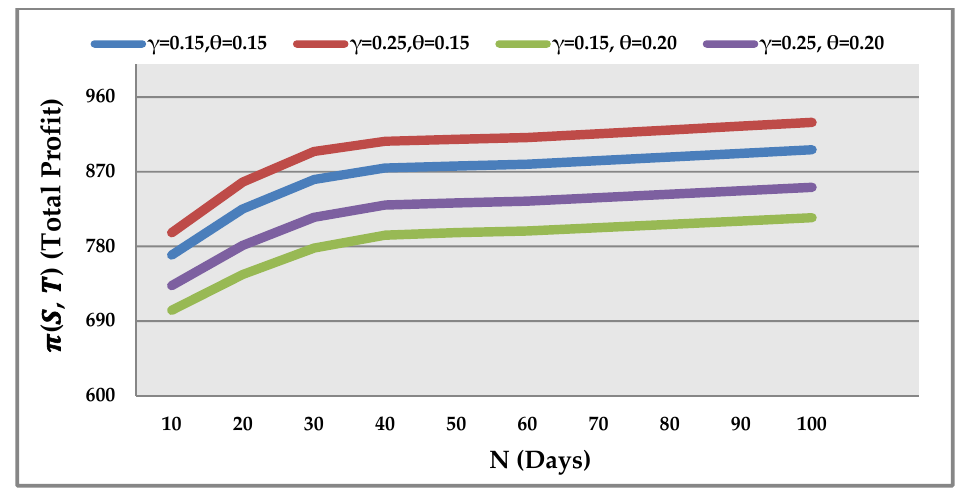
Figure 3. Effects of deterioration rate θ and salvage value γ on Total Profit π ( S , T ) based on Tables 2 and 3.